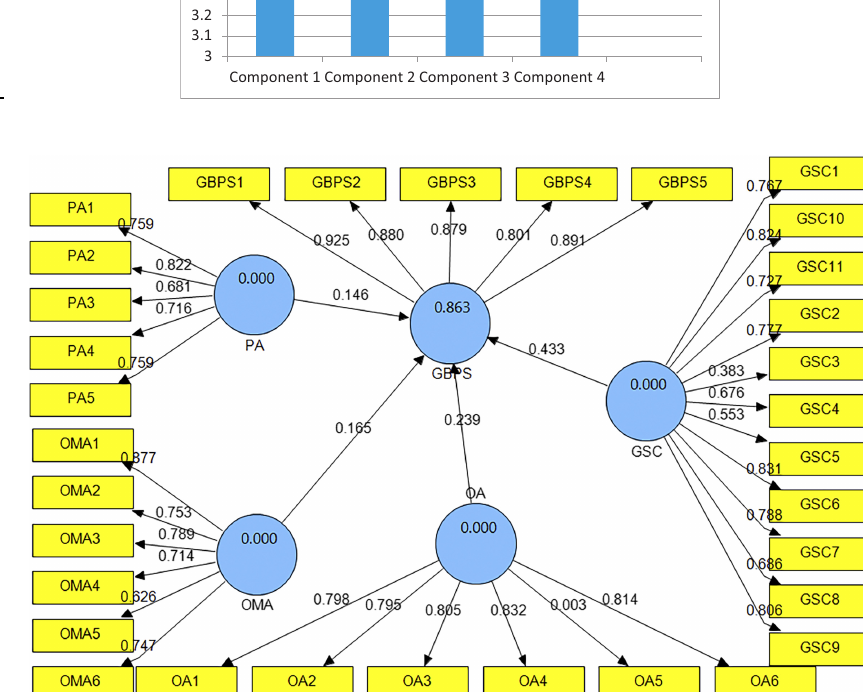
Figure 4. The initial